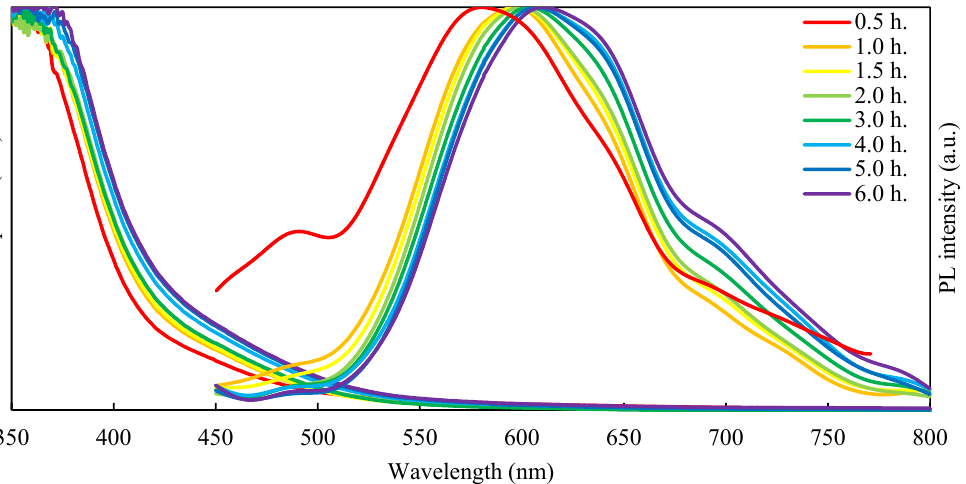
Figure 5. PL and absorption spectra of AgInS 2 QDs obtained at different intervals after nucleation.